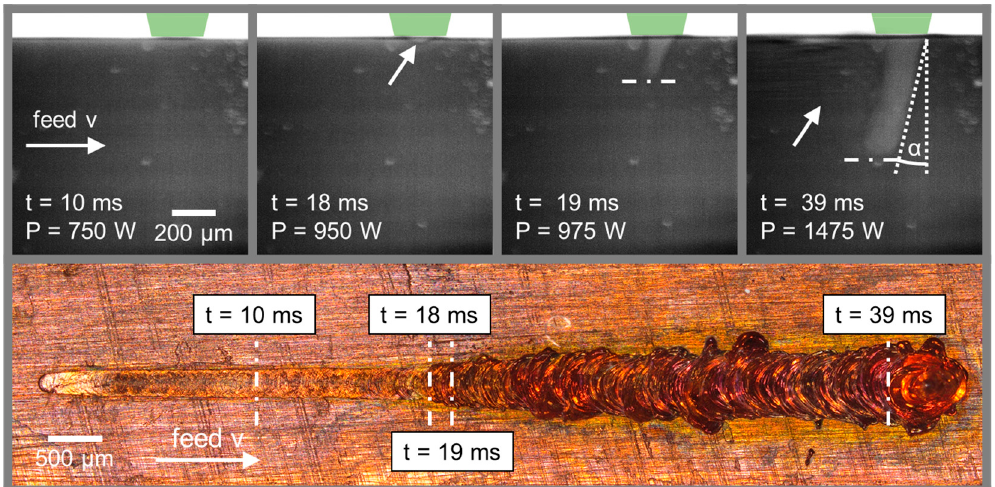
Figure 5. (Upper) X-ray video sequence of laser beam welding of copper using 515 nm laser radia- Figure 5. ( Upper ) X-ray video sequence of laser beam welding of copper using 515 nm laser radiation, tion, P = 500 W–1500 W, v = 200 mm/s; ( Lower ) corresponding top view of the weld seam. P = 500 W–1500 W, v = 200 mm/s; ( Lower ) corresponding top view of the weld